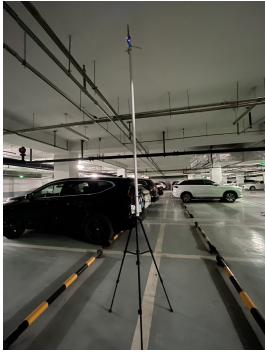
Figure 8. Experimental scene graph.